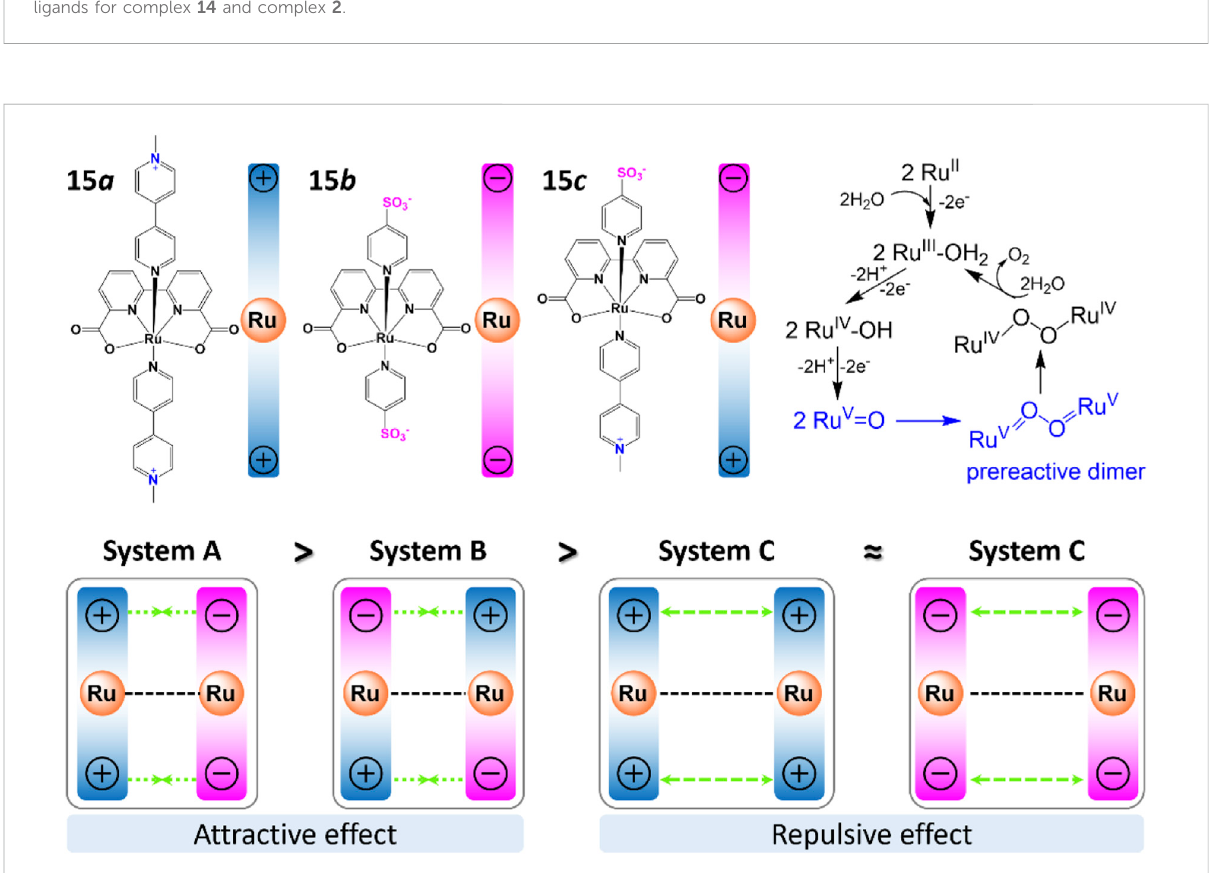
FIGURE 6 Effect of electrostatic interactions on Ru-bda catalysts, adapt with permission from J. Am. Chem. Soc. 2021, 143, 6, 2,484 – 2,490. Copyright 2021 American Chemical Society.